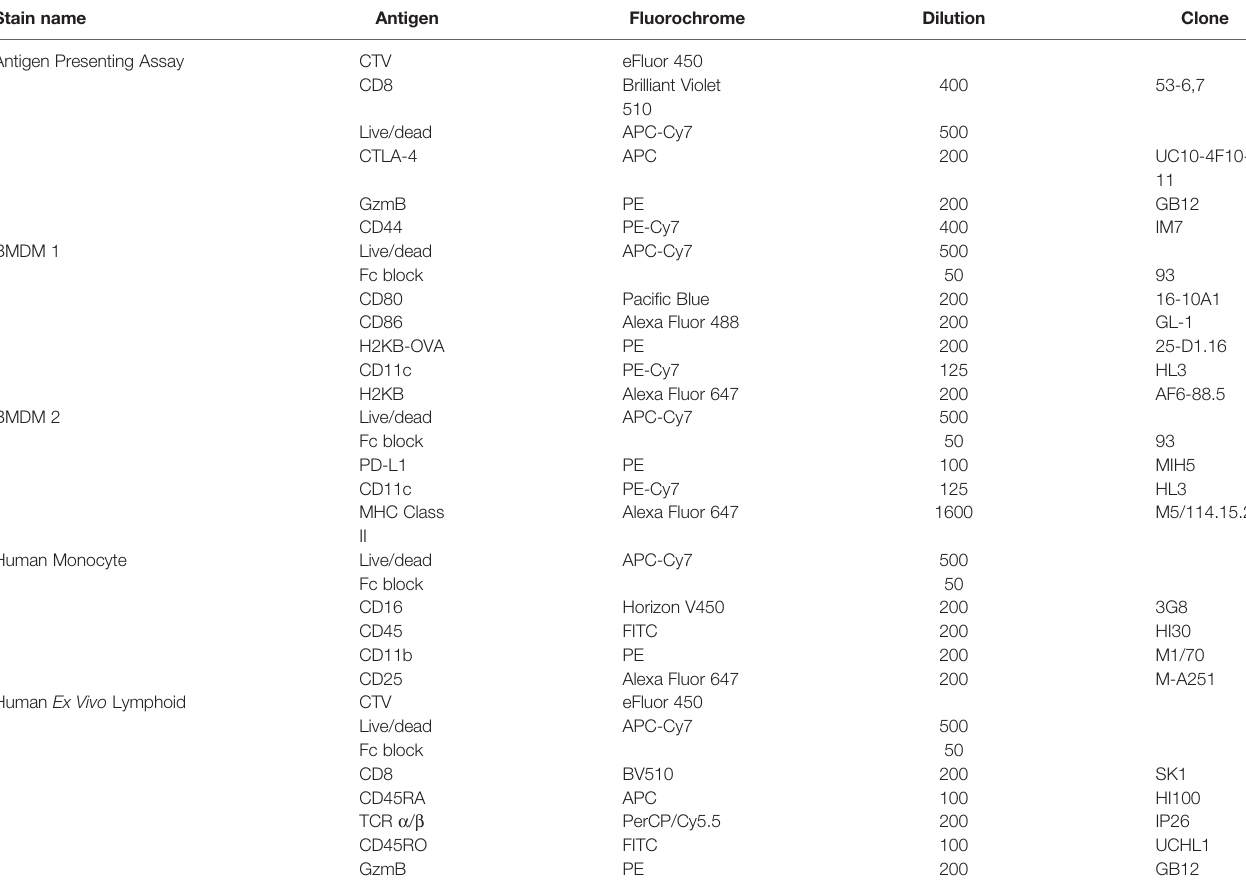
TABLE 1 | Antibodies and stains used for different analyses performed with fl ow